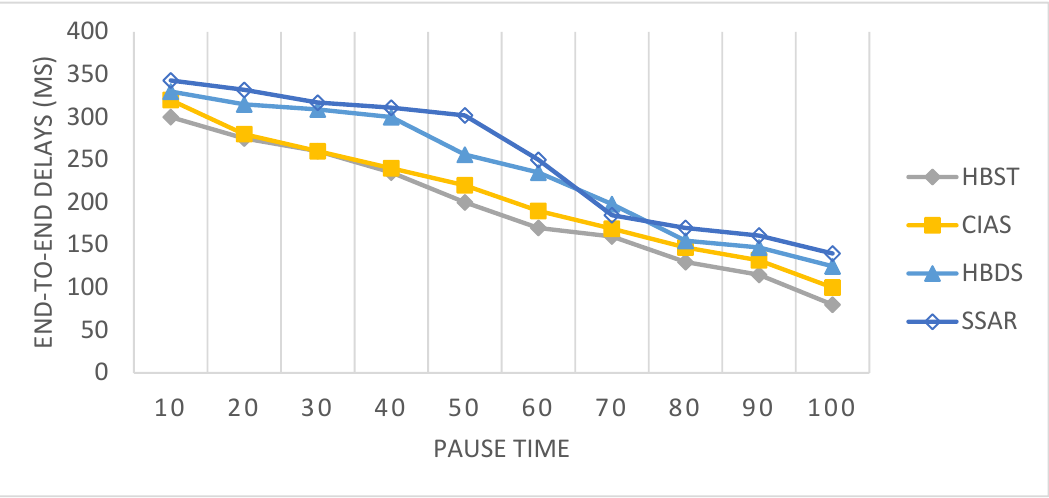
Figure 5. End-to-end delays for a network having 25% selfish nodes.